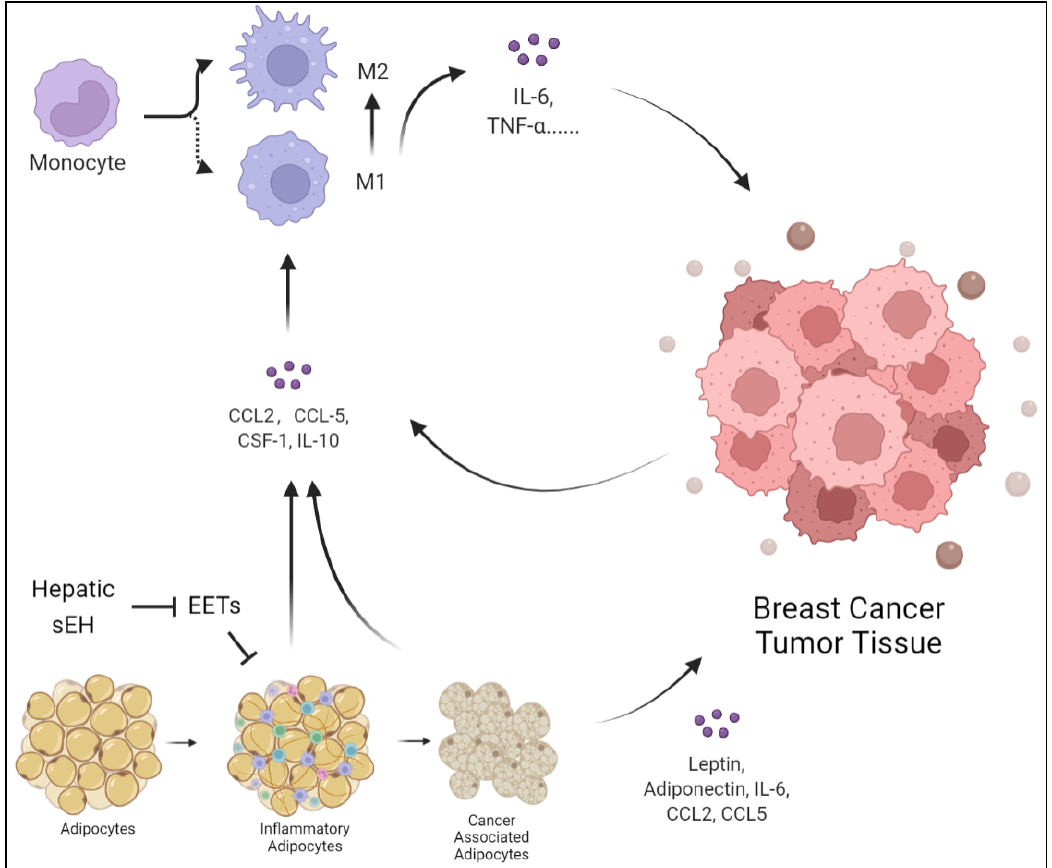
Figure 2. Adipocytes can be transformed into inflammatory cells under hepatic injury, releasing CCL2, CCL5, CSF-1, and IL-10. The products of inflammatory adipocytes can promote monocytes and macrophages to release IL-6 and TNF- α, polarize into M2 macrophages, and t hus promote tu- mor growth. At the same time, the hepatic sEH overexpression degrades EETs, which inhibit the suppressive effect on inflammatory adipocytes. Additionally, BC cells induce adipocytes to trans- form into cancer-associated adipocytes and highly express leptin, adiponectin, IL-6, CCL2, and